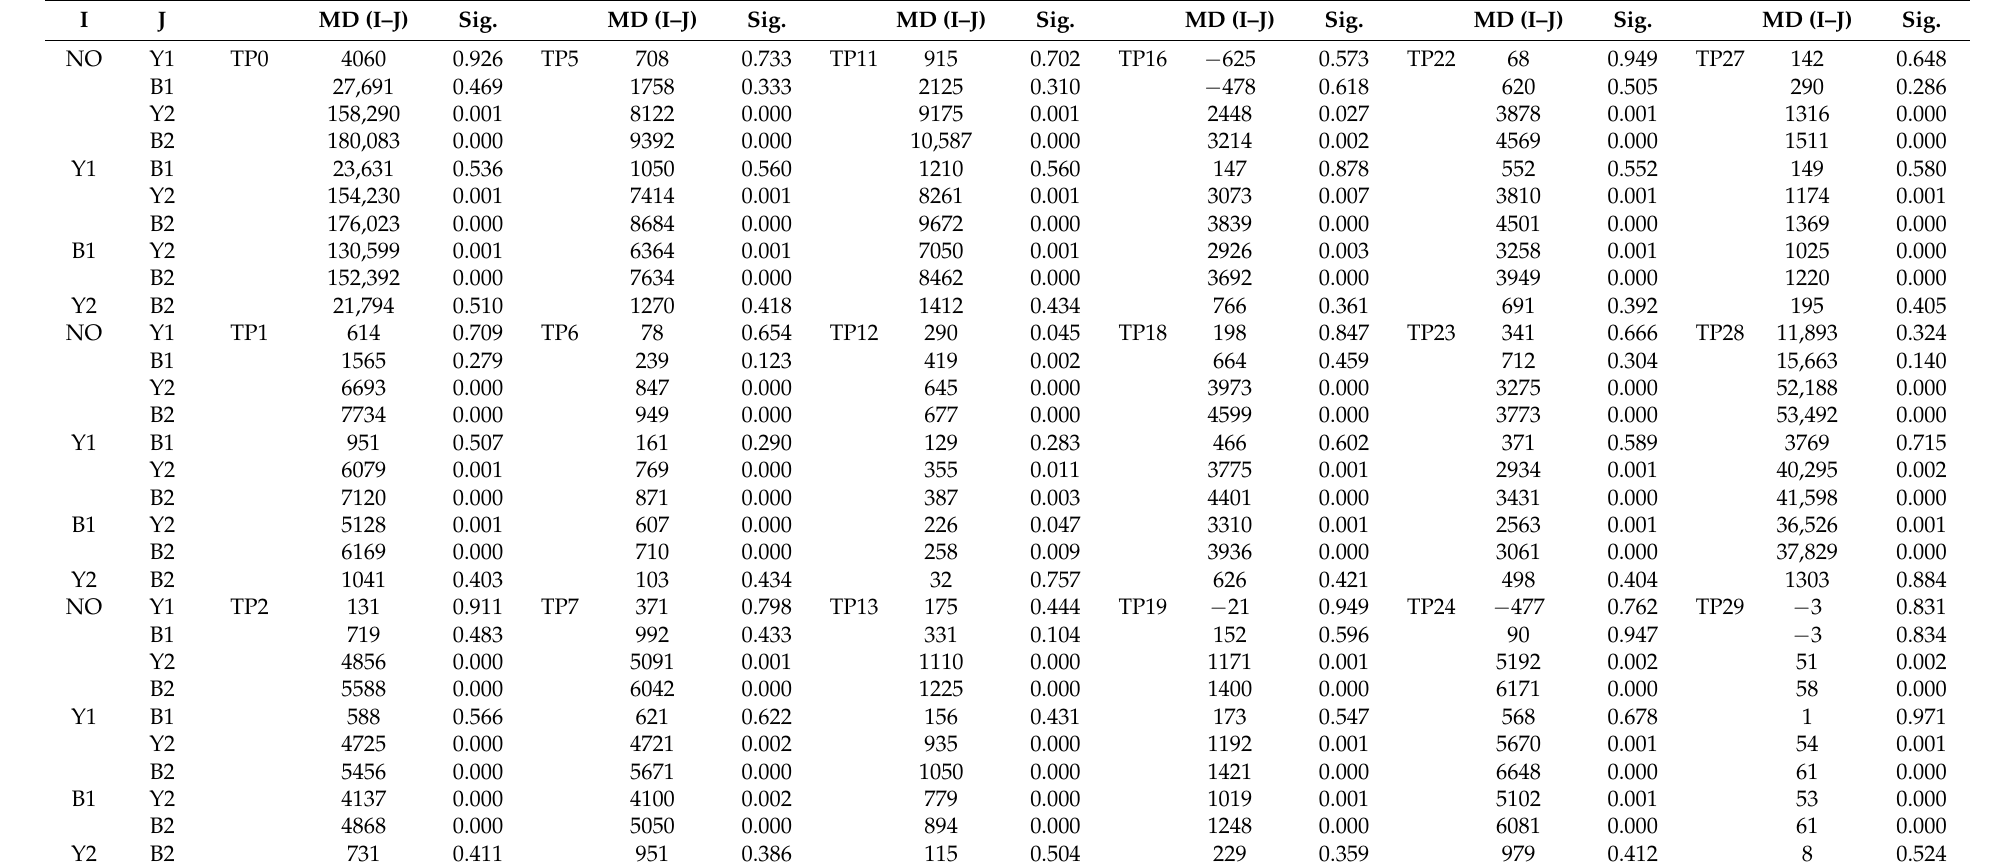
Table A4. Total population—post hoc tests—multiple comparisons using